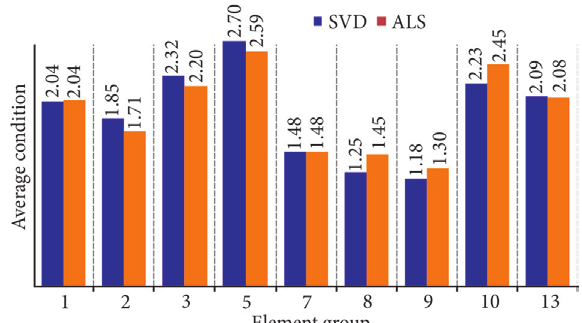
Fig. 2. Mean values of Group No. 2 (slab bridges) data of first inspection cycle